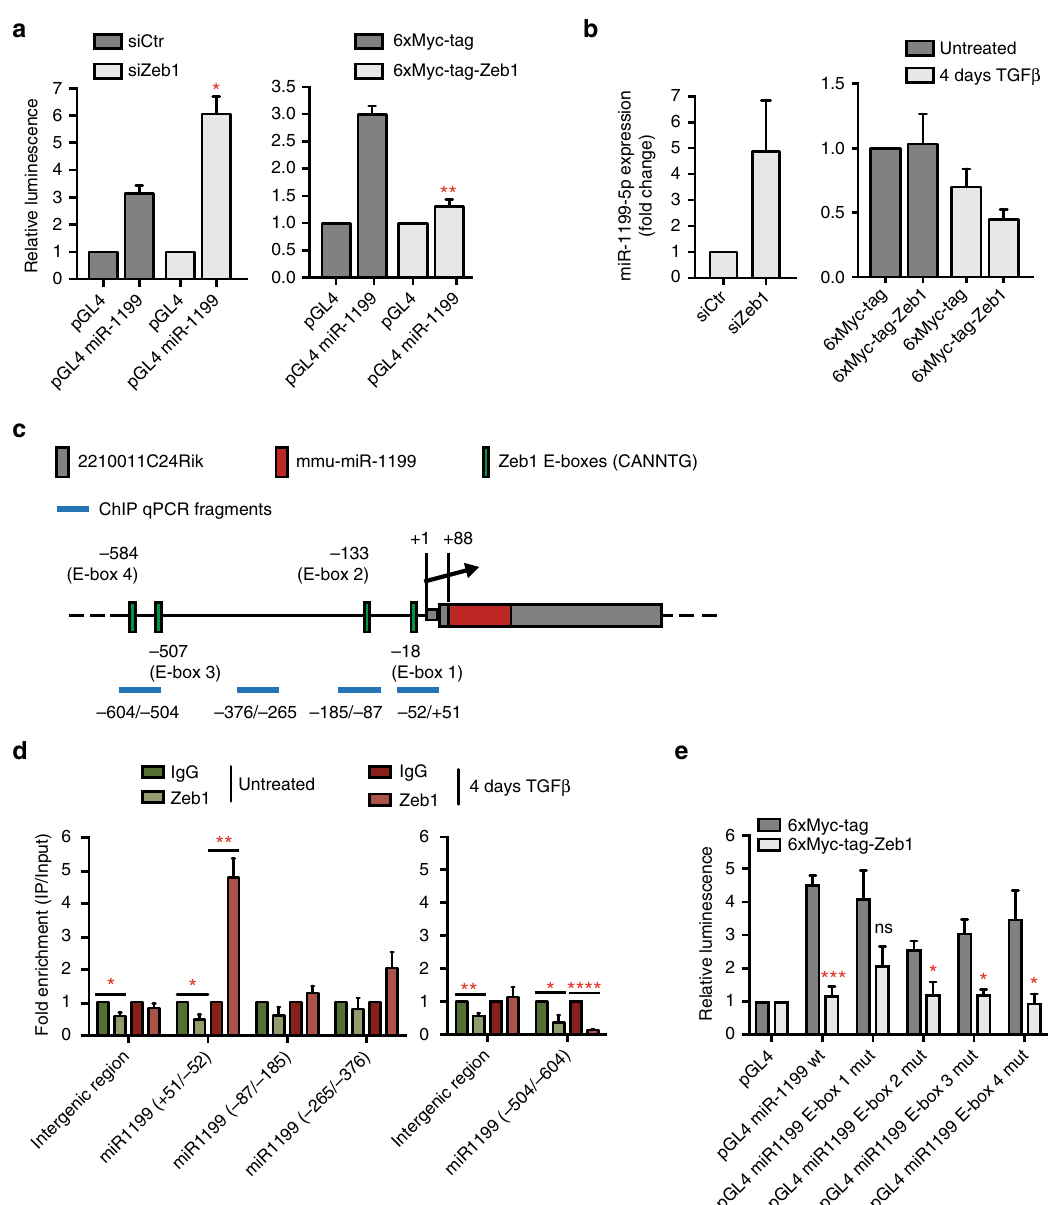
Fig. 5 Zeb1 directly regulates miR-1199-5p expression. a Zeb1 controls the promoter activity of the miR-1199 gene. NMuMG/E9 cells were transfected with a miR-1199 promoter Fire fl y luciferase reporter construct, a Renilla luciferase reporter construct as well as with (left) a siRNA against Zeb1 (siZeb1) or a negative control siRNA (siCtr) or (right) a Zeb1 expression construct (6xMyc-tag-Zeb1) or a negative control construct (6xMyc-tag). Cells transfected with siRNAs were cultured for 4 days with TGF β , while cells transfected with 6xMyc or 6xMyc-tagged Zeb1 were cultured in the absence of TGF β . Relative luminescence (Fire fl y/Renilla) was calculated and normalized to the control Fire fl y luciferase reporter (pGL4; mean fold changes ± s.e.m.; n = 3; signi fi cance determined by an unpaired, two-sided t test; * P < 0.05, ** P < 0.01). b Zeb1 controls miR-1199-5p transcript levels. NMuMG/E9 cells were transfected with siRNAs (left) and Zeb1 constructs (right) as described in a and further cultured in the absence or presence of TGF β . MiR-1199-5p transcript levels were examined by RT-PCR analysis (mean fold changes ± s.e.m.; left: n = 5; right: n = 3). c Schematic presentation of the genomic localization of the murine miR- 1199 gene and its promoter region. Red: mmu-miR-1199; grey: 2210011C24Rik gene; green: E-boxes (CANNTG, N = G or C); blue: promoter fragments examined by ChIP-qPCR analysis. d Zeb1 directly binds to the miR-1199 promoter. Chromatin of Py2T cells cultured in the absence (green) and presence of TGF β (red) was subjected to chromatin immunoprecipitation with antibodies against Zeb1 followed by RT-PCR analysis using primers amplifying different regions of the miR-1199 promoter illustrated in c . An intergenic region was used as negative control. Data were normalized to control IgG and are presented as mean fold enrichment above background ± s.e.m. ( n = 3; signi fi cance determined by an unpaired, two-sided t test; * P < 0.05, ** P < 0.01, **** P < 0.0001). e Analysis of E-box-binding motifs in the miR-1199 promoter as potential Zeb1-binding sites. NMuMG/E9 cells were transfected and cultured as described in a (right). Relative luminescence (Fire fl y/Renilla) was calculated as described in a (mean fold changes ± s.e.m.; n = 3; signi fi cance determined by an unpaired, two-sided t test; * P < 0.05, *** P <